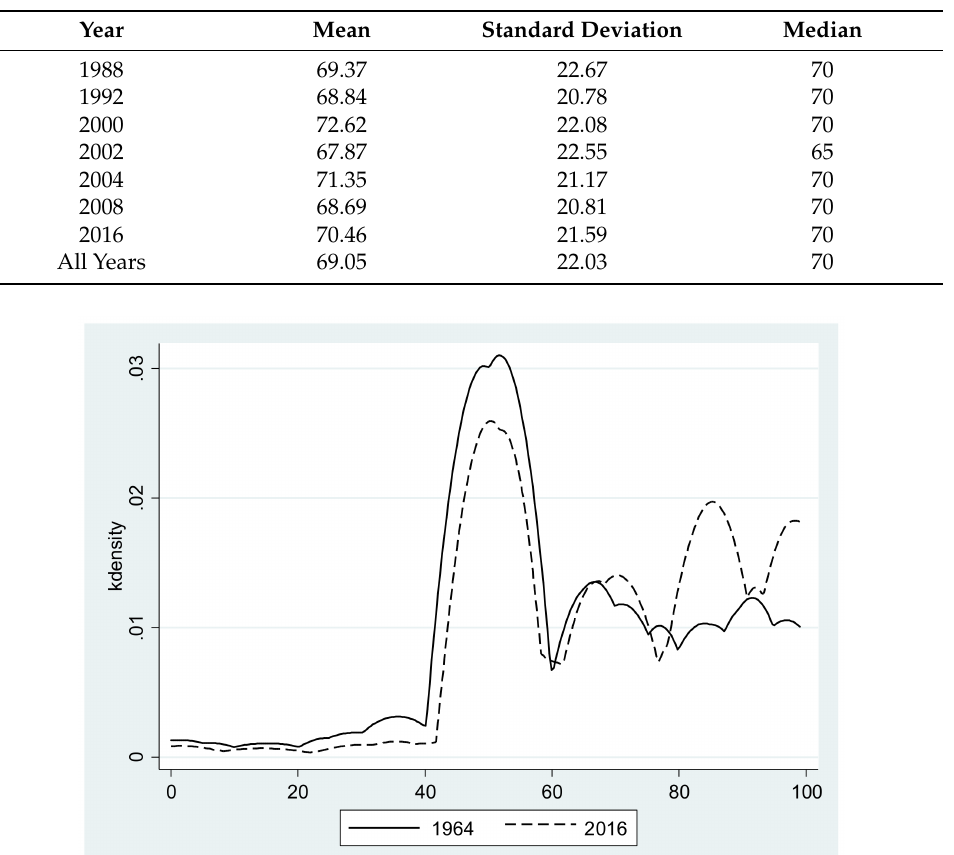
Figure 1. Jewish feeling thermometer kernel density plots, 1964, 2016. Source: American National Election Studies,